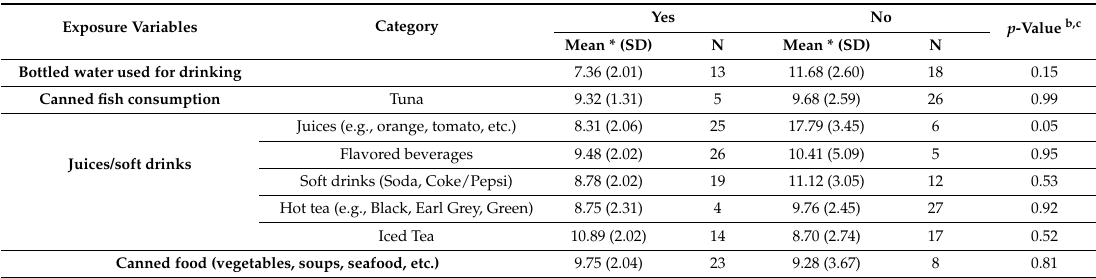
Table 6. Associations between dietary consumption and creatinine-adjusted Mono-(2-ethyl-5-oxohexyl) phthalate (MEOHP) ( µ g/g) concentrations in urine (N = 31) a . Exposure